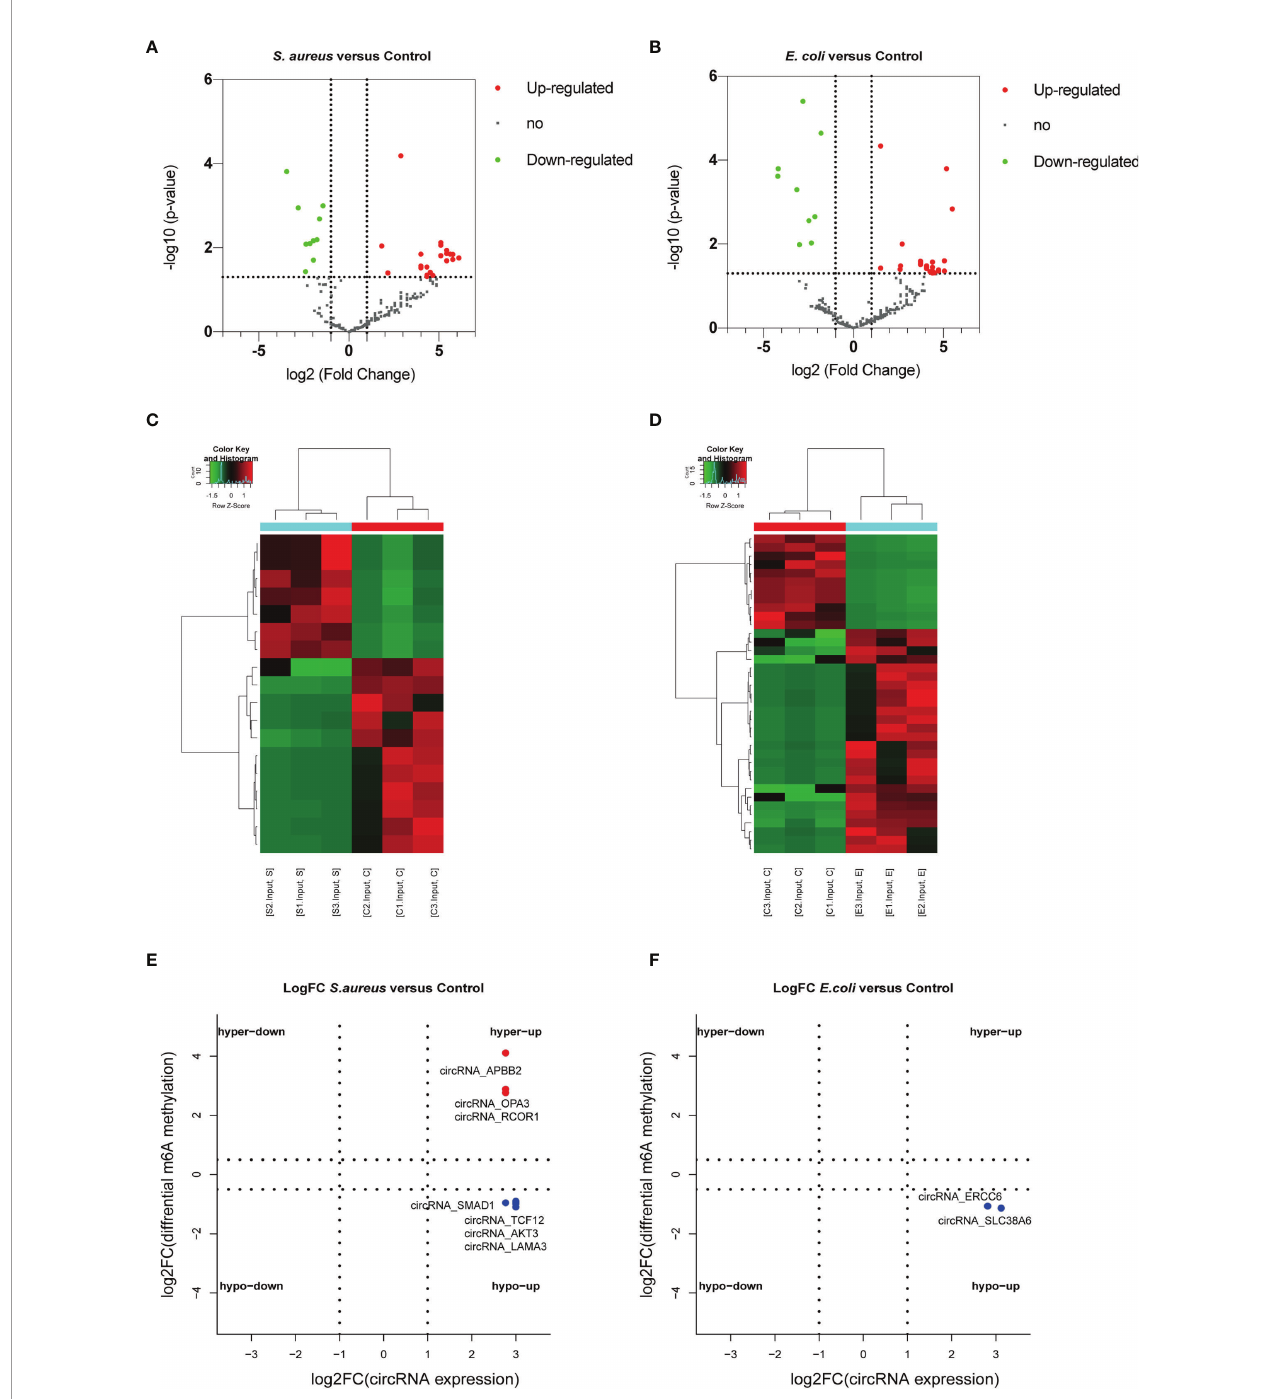
FIGURE 7 | Conjoint analysis of circRNA with or without m 6 A modi fi cation. Volcano plot showing the differentially expressed circRNAs in the (A) S. aureus group and (B) E. coli group. Heatmap illustrating the differentially expressed circRNAs in the (C) S. aureus group and (D) E. coli group. Conjoint analysis between the expression level and m 6 A modi fi cation in the (E) S. aureus group and (F) E. coli